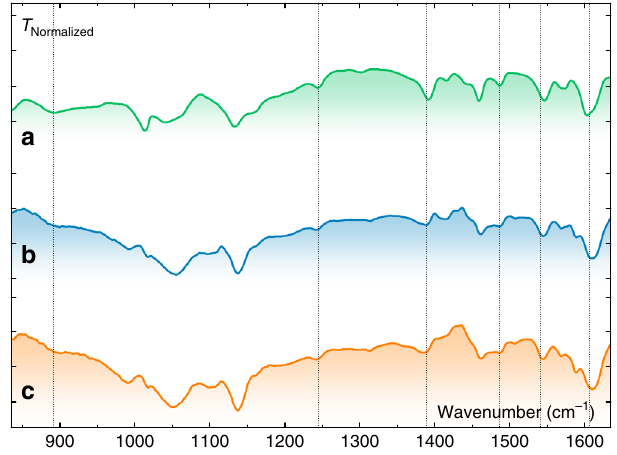
Fig. 2 ATR-IR spectrum of Co-qPyH complex catalyst. From a powder ( a ), deposited on m-TiO 2 before ( b ) and after ( c ) 1 h of electrolysis performed in 0.1 M KHCO 3 electrolyte saturated with CO 2 (pH 6.8) at − 0.56V